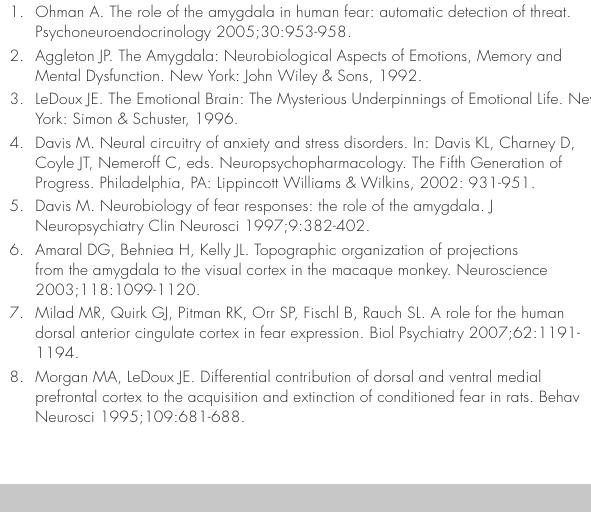
Table II. Brain areas involved in fear learning processes Area